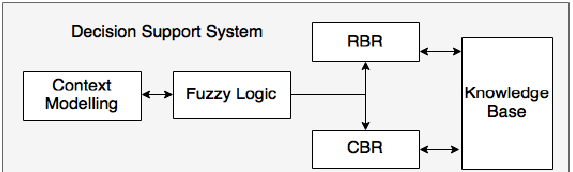
Figure 3. The decision support system (DSS) architecture. Rule-based reasoning (RBR) and case-based reasoning